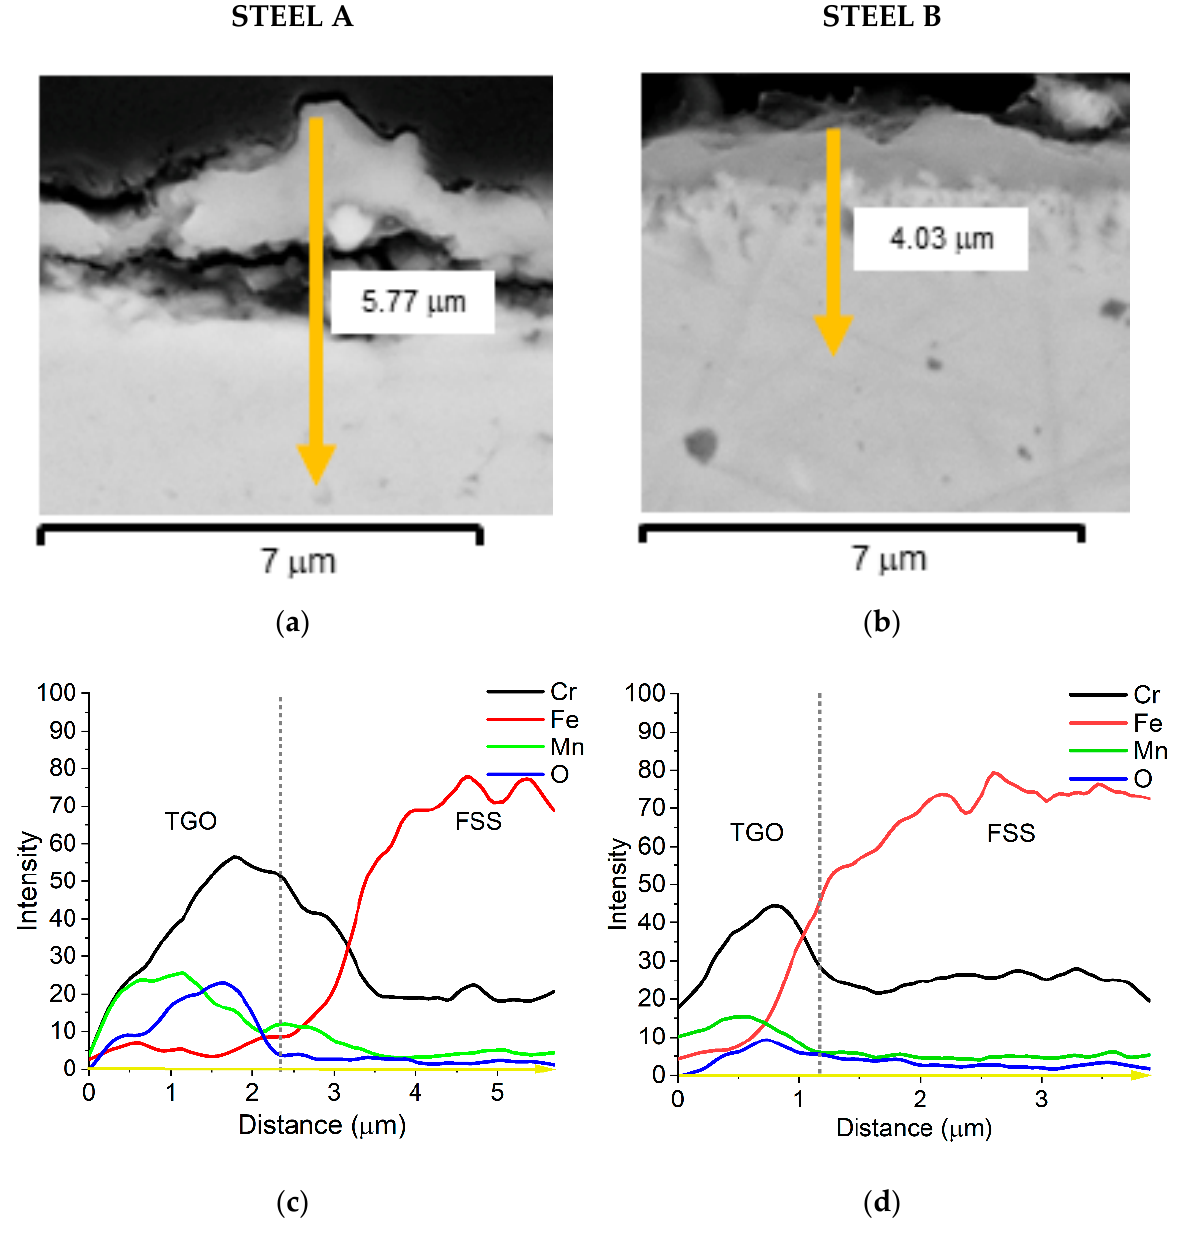
Figure 9. SEM-SE micrographs of Steel A ( a ) and Steel B ( b ) cross-sections, 20,000 × ; EDS semi-quantitative distribution profiles of elements of Steel A ( c ) and Steel B ( d ) performed along the yellow arrow of ( a , b ). Cr is mainly concentrated at the interface TGO/metallic substrate forming the inner layer of chromia while the external layer, mainly made of spinel oxide, contains a higher amount of Mn. The presence of Cu and of the other minor elements was too low to be expressed in this graph. A quantitative profile was then acquired to better highlight such detail and the results are presented in Figures 10 and